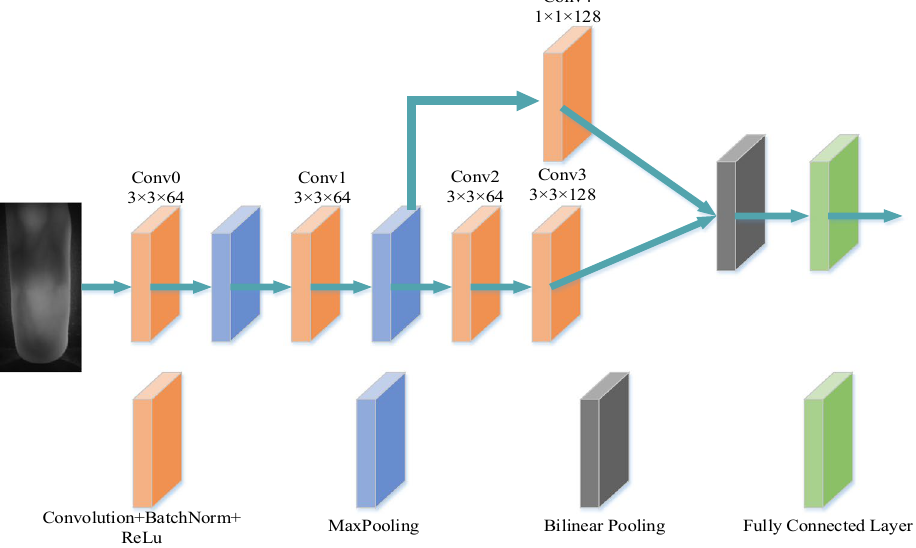
Figure 1. Multi-scale feature bilinear fusion network